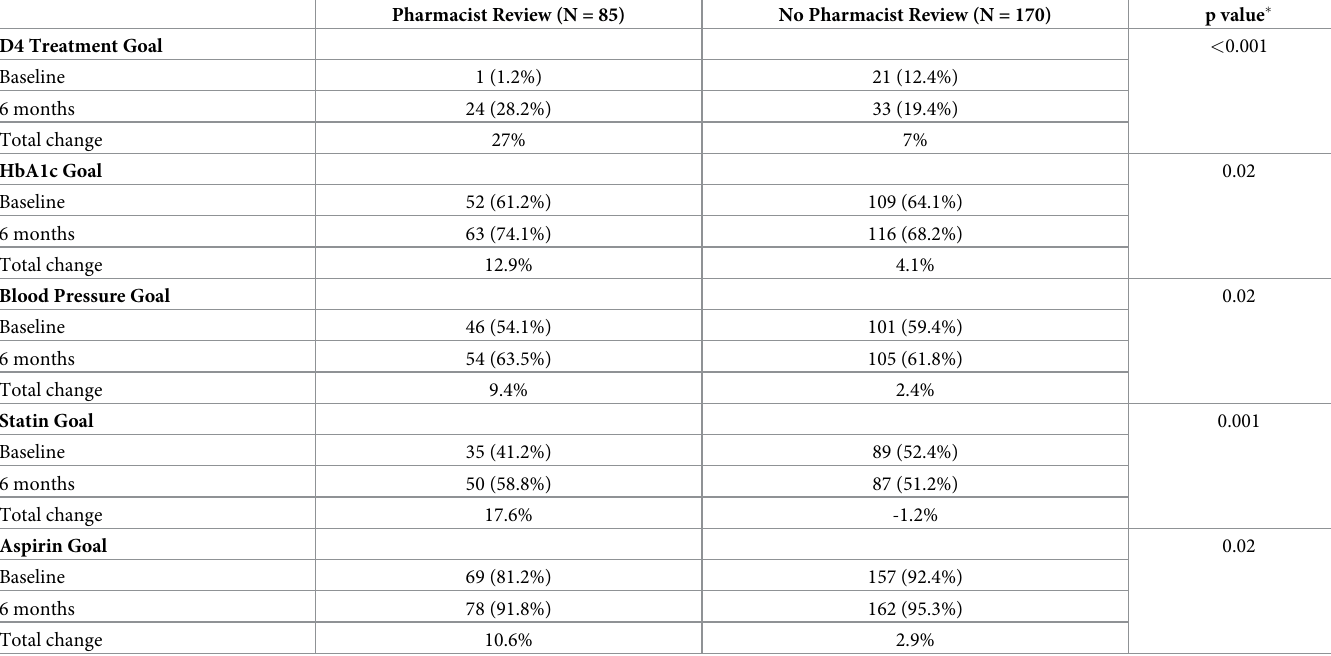
Table 2. Patients meeting treatment goals at baseline versus 6 months.